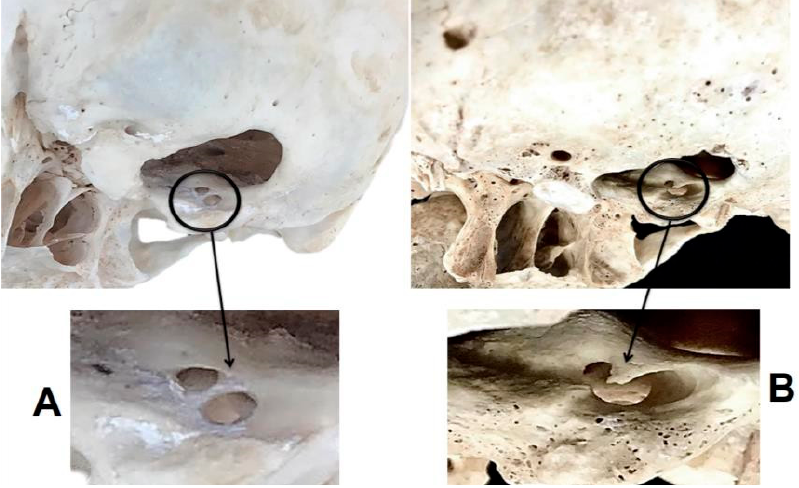
Figure 2. Anatomical characteristics of the hypoglossal canals: ( A ) present septal structure, ( B ) present spur structure.